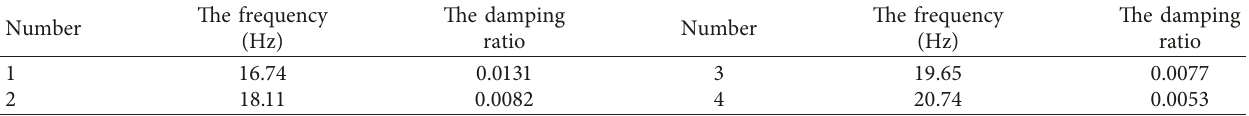
Table 5: Fourth stage of natural frequency and damping ratio of structure B1 before inputting seismic motion.